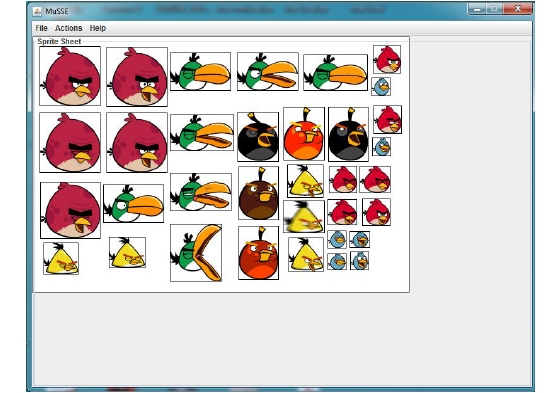
Fig. 17. Sprite sheet with high connectivity. Source: MuSSE with sprite sheet image from the game Angry Birds©.